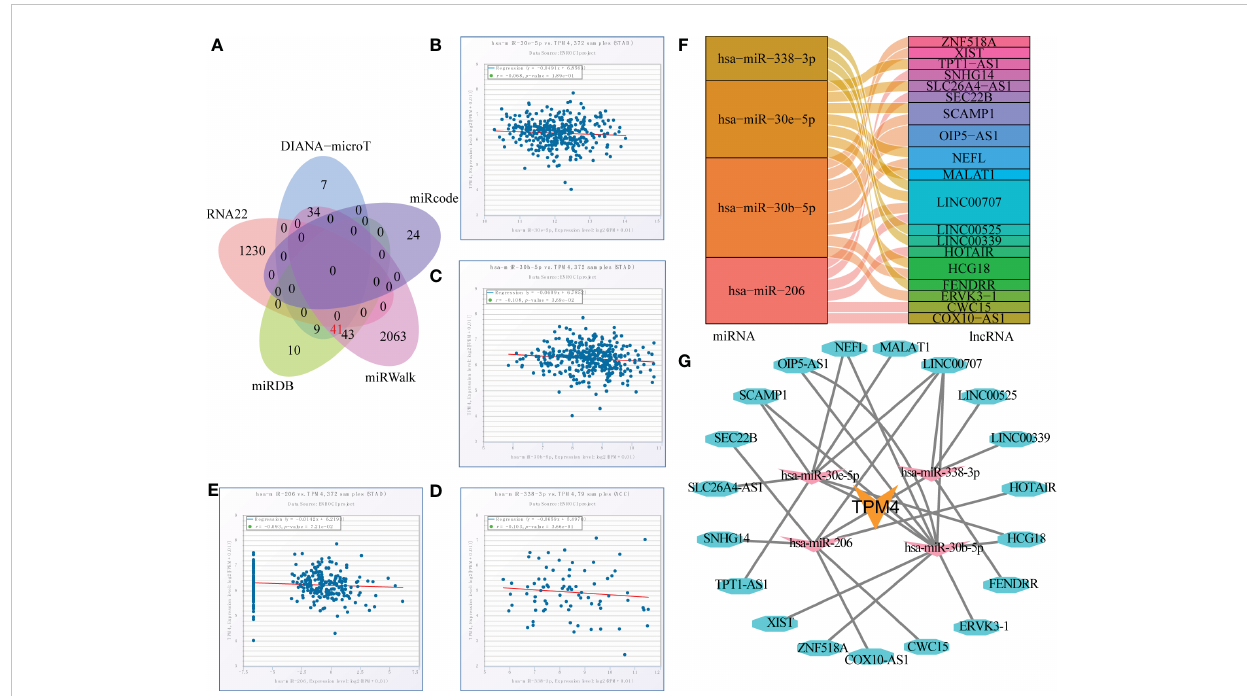
FIGURE 8 TPM4-related pivotal ceRNA network construction in STAD. (A) Venn diagram of predicted TPM4 target miRNAs in RNA22, DIANA-mircoT, miRWalk, miRcode, and TargetScan. (B-E) Correlation analysis of TPPM4 and the target miRNAs in scatter plots. hsa -miR-30e-5P (B) , hsa -miR-30b-5p (C) , hsa -miR-338-3P (D) , and hsa -miR-206 (E) . (F) Sankey diagram of target miRNAs and their target lncRNAs. (G) The lncRNA-miRNA-TPM4 regulatory network was constructed for STAD using